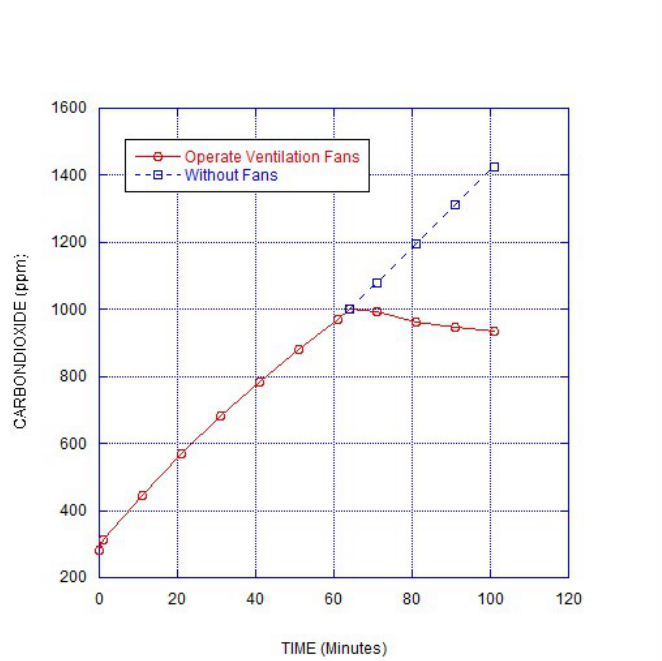
Figure 4. Using Equation 2 to project increasing rate of CO 2 to determine the ability to dissipate CO 2 by installed ventilation